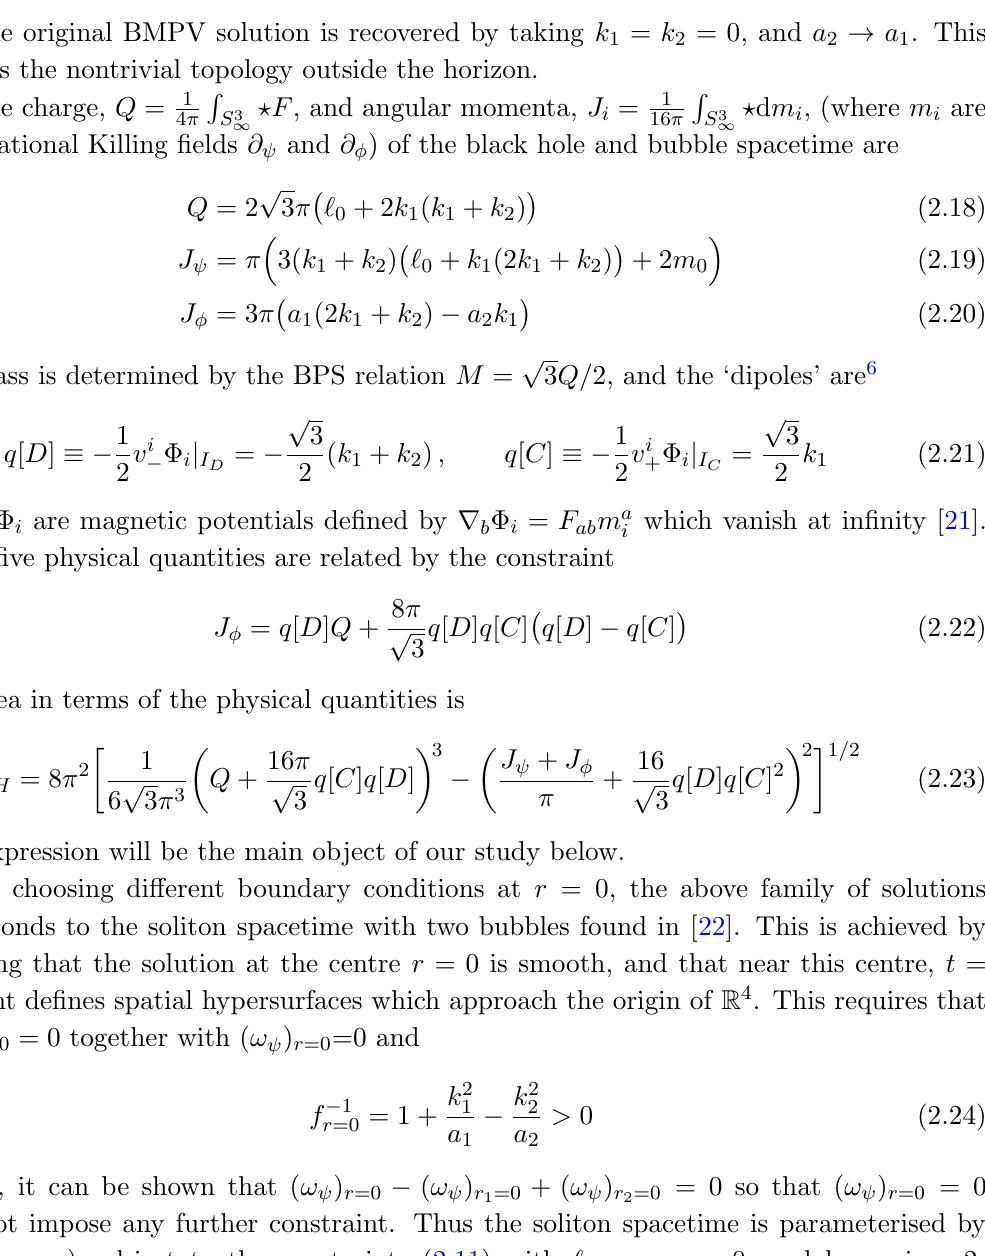
= k = 0, and a ! a . This 1 2 2 1